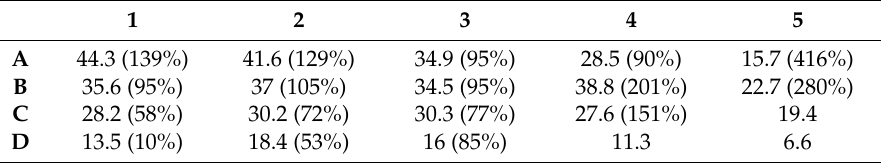
Table 6. SNR (dB) for the t -statistic on step heating thermal data.